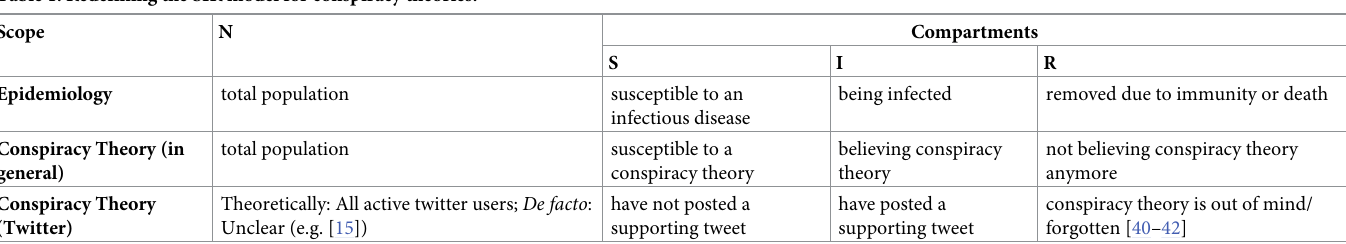
Table 1. Redefining the SIR model for conspiracy